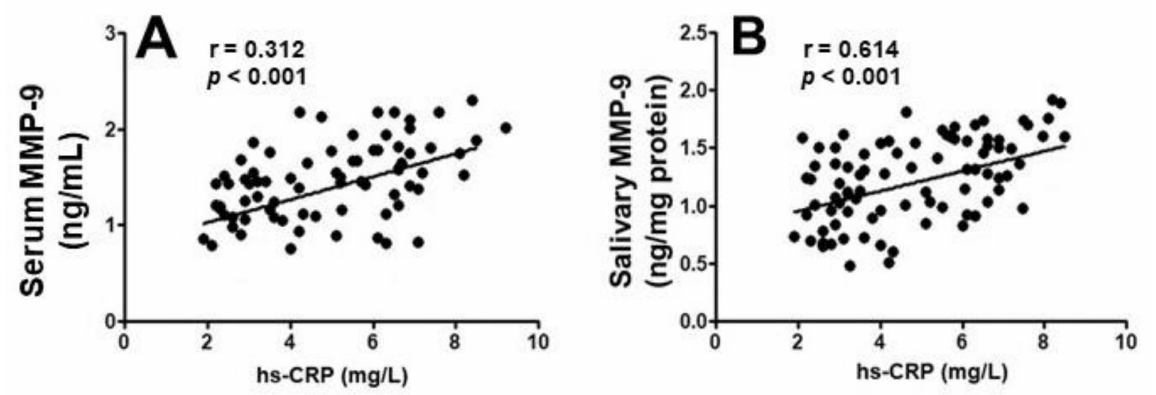
Figure 2. Correlation among MMP-9 concentrations in serum ( A ) and saliva ( B ) with hs-CRP.